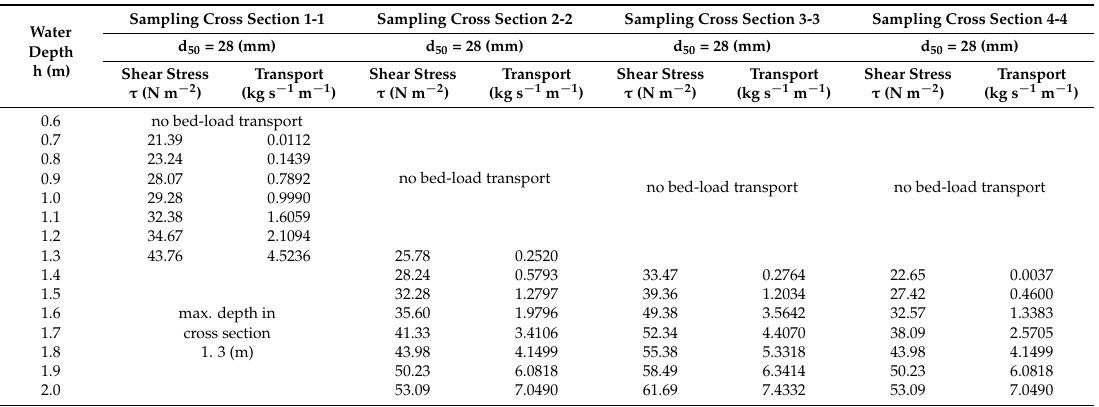
Table 5. Unit bed-load transport at the Lososina River—prior to the training works.